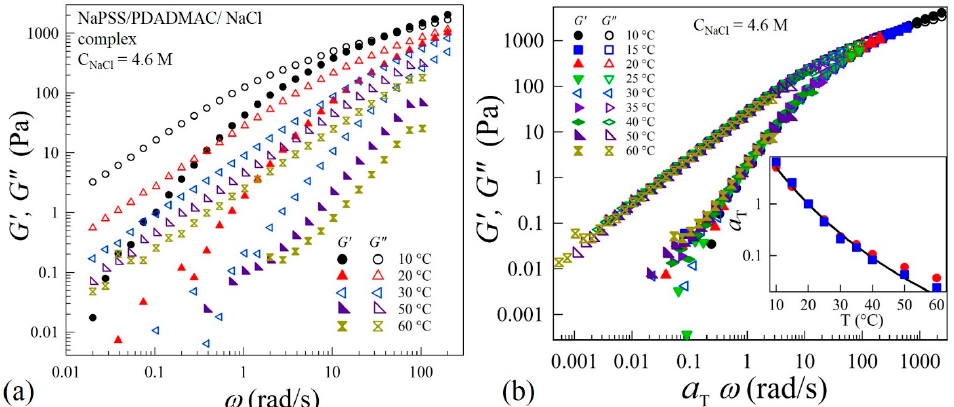
Figure 2. ( a ) Variations of elastic G’ and viscous G” moduli as functions of applied frequency ω at different temperatures in linear viscoelastic regime of coacervates prepared at C NaCl = 4.6 M, ( b ) time-temperature superposition (TTS) at a reference temperature T r = 20 ◦ C of the data shown in ( a ). The inset of ( b ) shows the dependence of shift factors a T ( (cid:4) ) and a (cid:48) ( ) on temperature T . The solid line is a fit to the Williams–Landel–Ferry (WLF) equation: ln ( a T ) = − C 1 ( T − T r ) / ( C 2 + T − T r ) , where C 1 = 7.3, C 2 = 45 and T r = 20 ◦C.